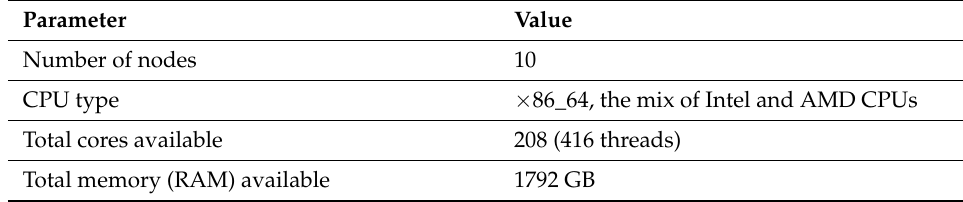
Figure 4. The data-processing pipeline. Table 3. Hadoop cluster